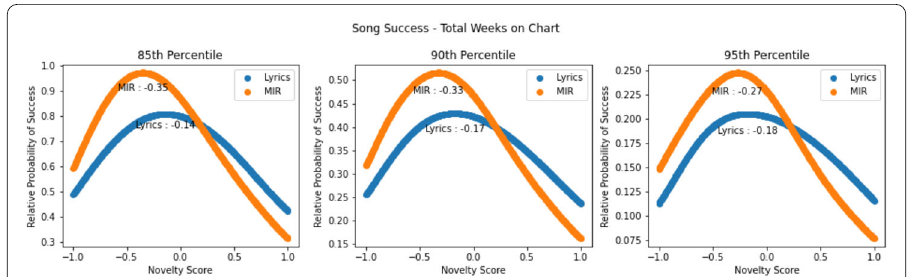
Figure 5 Relative probability of success in reaching the 85th, 90th, and 95th percentile of total weeks on chart across a range of MIR novelty scores, and across a range of lyric novelty scores. Since the relative probability values are a summation of probability estimates of a generated data set, they are dependent on the total number of data points generated for our sample, and should not be treated as an absolute probability value